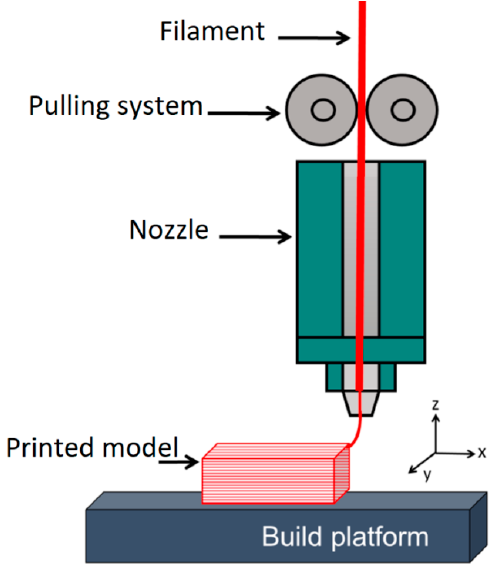
Figure 1. Schematic representation of the FDM process [40].